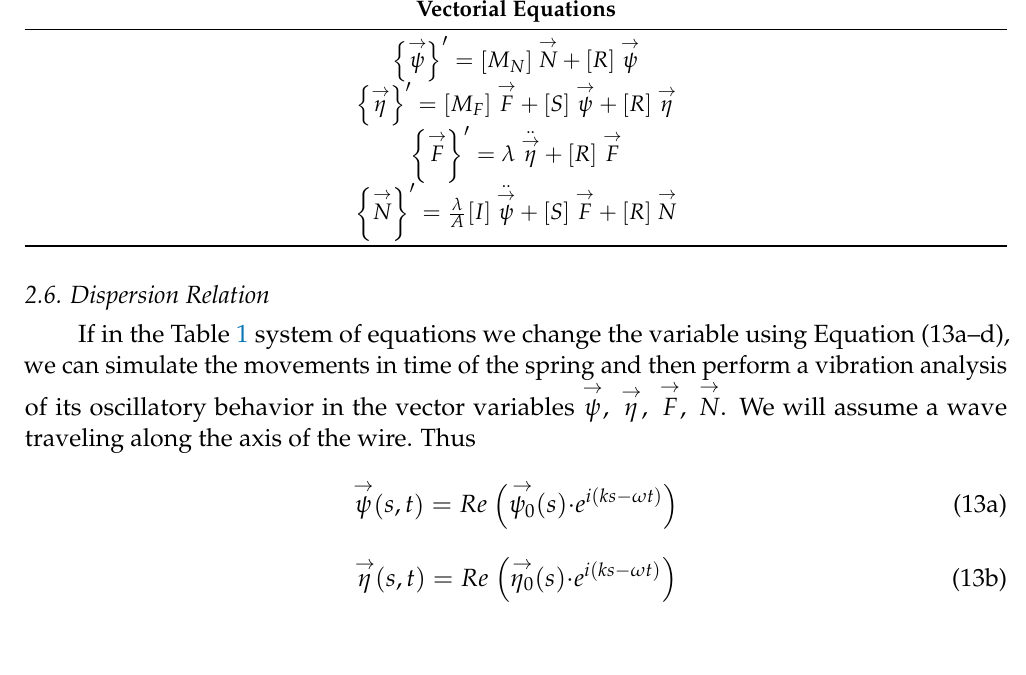
Table 1. System of Vectorial Equations to model spring behavior. Vectorial